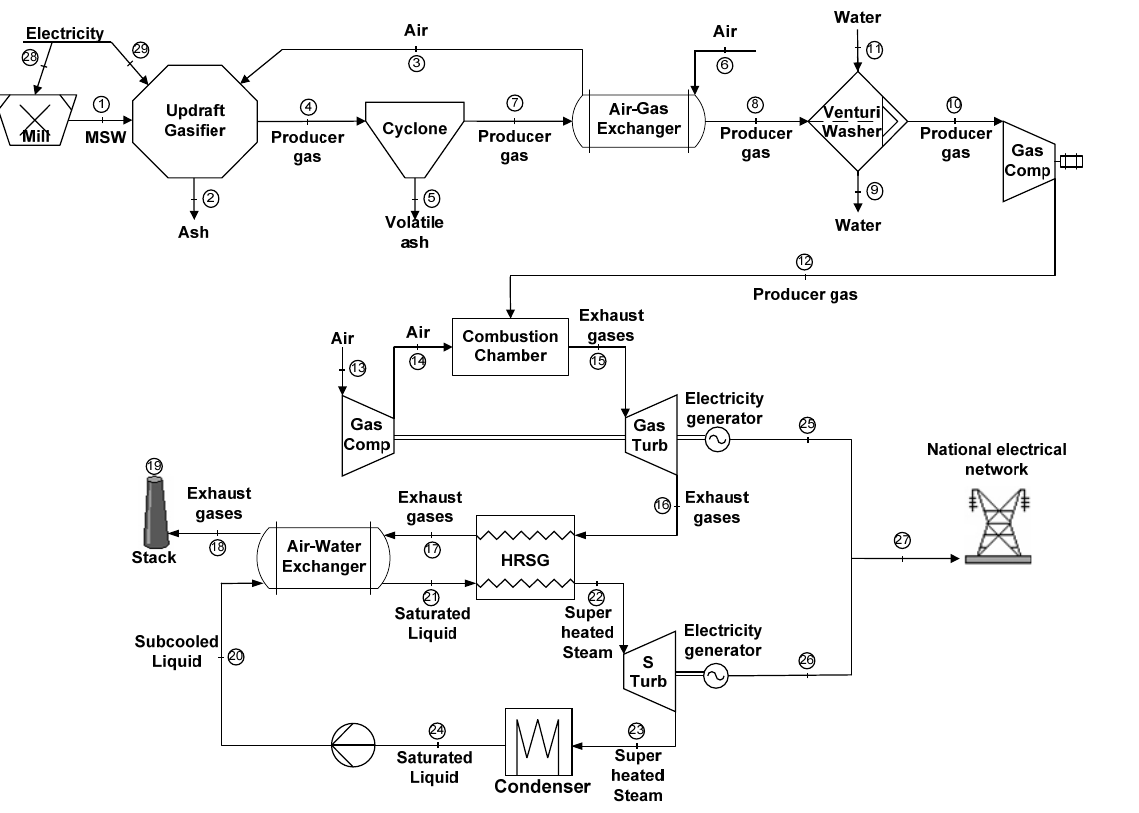
Figure 1. Simplified diagram of the WIG-GTCC system. Critical installation points of the plant were numbered and identified in Table 1. Mass and energy balance .